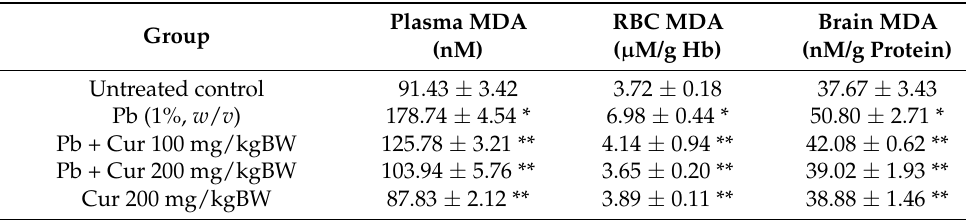
Table 2. The effects of curcumin treatment against lead-induced oxidative stress on malondialdehyde levels in plasma, RBC, and brain tissues after treatment 38 days.